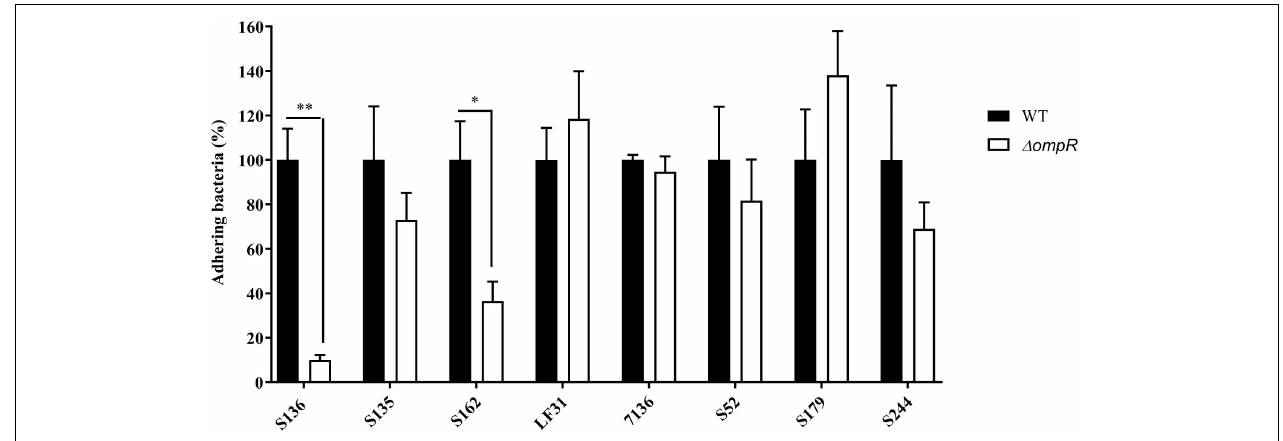
FIGURE 1 | Adhesion levels of AIEC WT and (cid:49) ompR mutants to intestinal epithelial cells T84. Adhesion assay was performed with T84 intestinal epithelial cells infected with WT (black bars) and (cid:49) ompR mutants (white bars) at a MOI of 10 bacteria/cell for 3 h. Results are expressed in %, considering 100% as adhesion level for the WT strain (means ± SEM, 5 independent experiments). ∗ p < 0.05, ∗∗ p < 0.01. Unpaired t test.